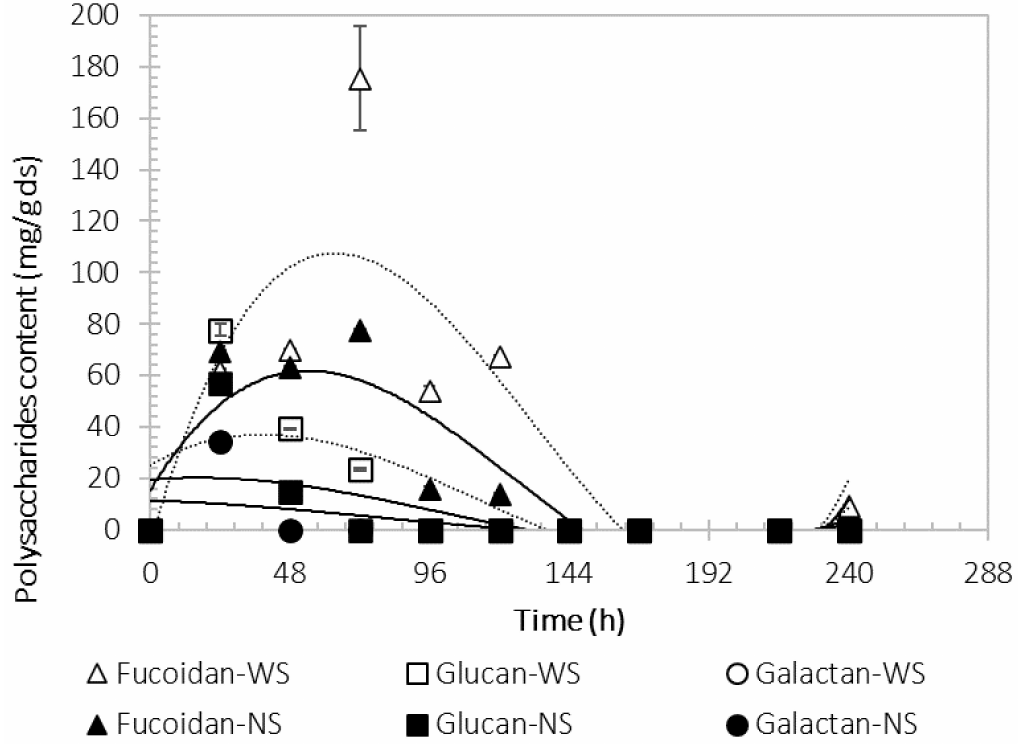
Figure 5. Polysaccharide content profile during Aspergillus niger M4 Sargassum fermentation process, using washed Sargassum (light color) and natural Sargassum (solid color) as